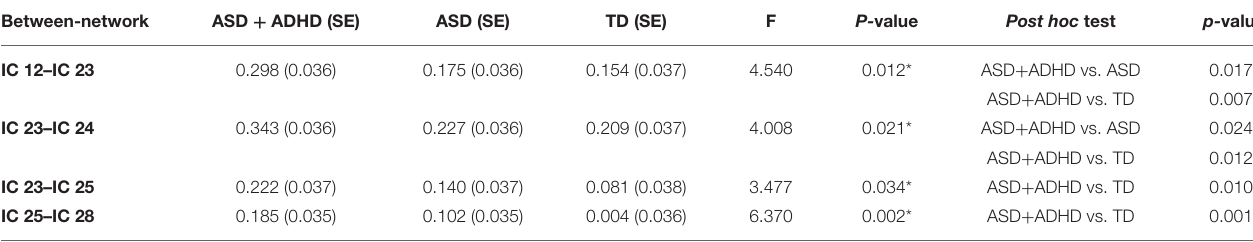
TABLE 3 | Between-network connectivity differences between ASD + ADHD and ASD groups.